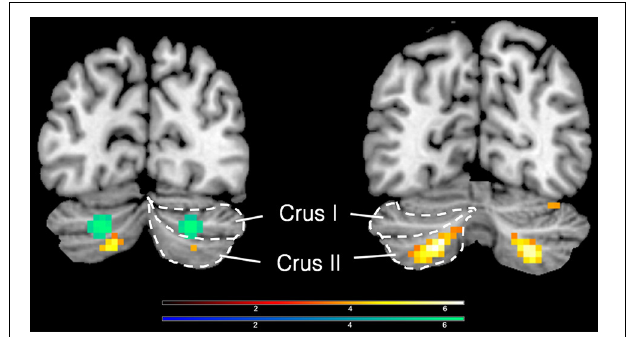
FIGURE 3 | Activations and deactivations in the cerebellum; yellow shows activations ( − 30 − 61 − 47/27 − 64 − 44) and green shows deactivations ( − 24 − 82 − 32/21 − 76 − 35), when an inclusive mask covering the whole cerebellum was applied.